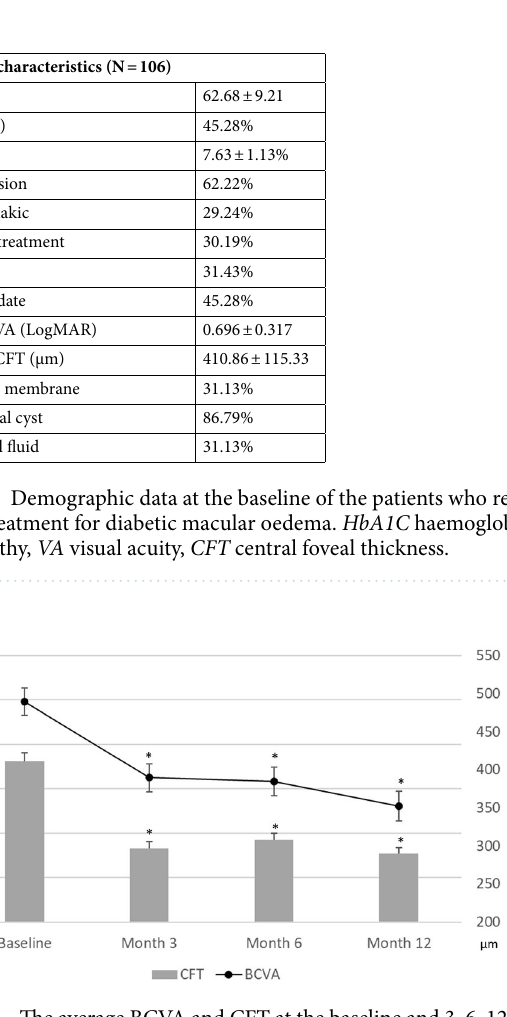
Figure 1. The average BCVA and CFT at the baseline and 3, 6, 12 months after anti-VEGF treatment for diabetic macular oedema. Both BCVA and CFT significantly improved compared with baseline at 3, 6, and 12 months after initial anti-VEGF treatment. BCVA best-corrected visual acuity, CFT central foveal thickness, VEGF vascular endothelial growth factor. *p < 0.001 (compared with